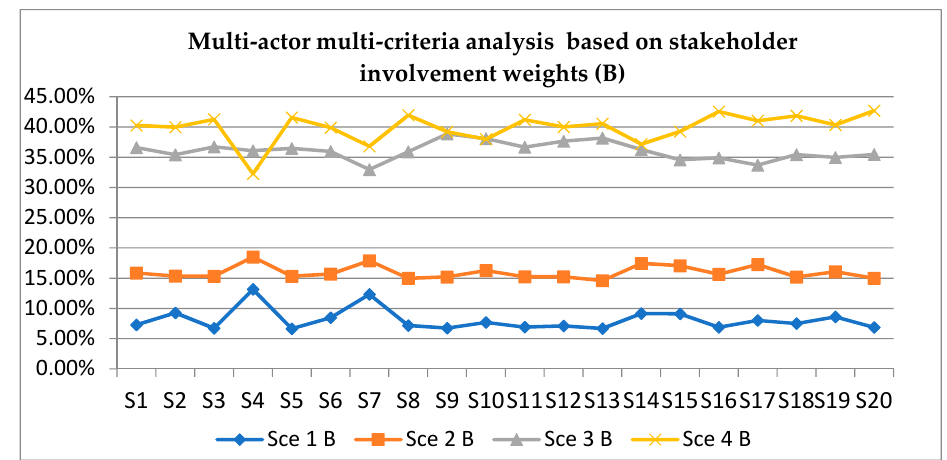
Figure 8. Results of multi-actor multi-criteria analysis with stakeholder weights (method B).